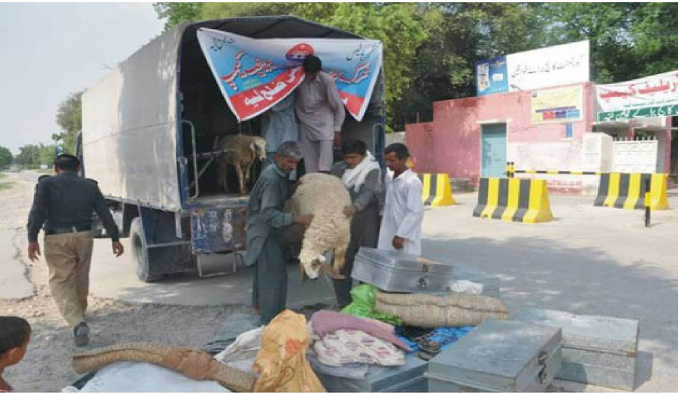
Figure 6. Rescue operation (2010) by district Police Layyah: Transferring flood affected family and its assets in Government College for Women